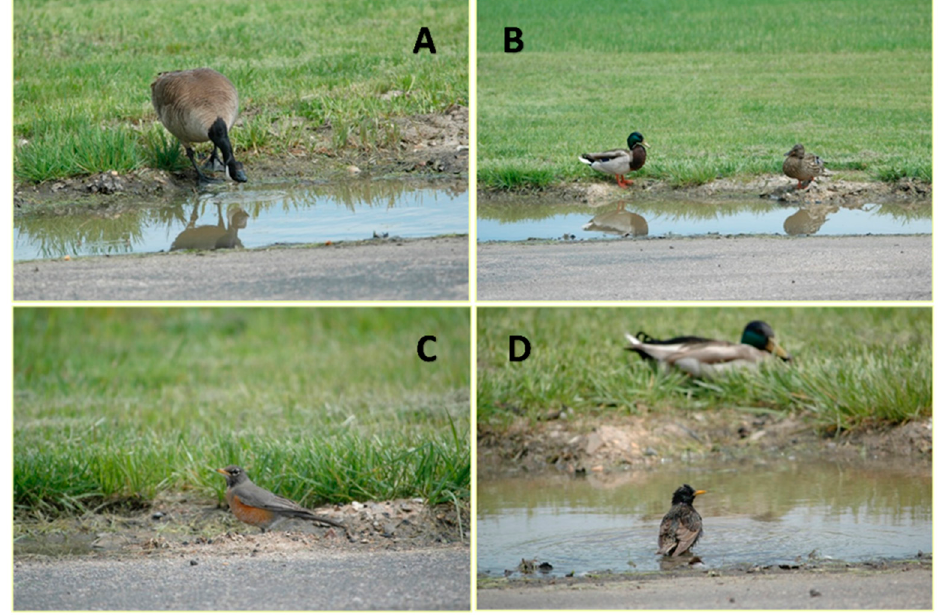
Figure 2. ( A ) Canada goose, ( B ) mallard, ( C ) American robin, ( D ) European starling (mallard in background) all sharing the same puddle over a short period of time.